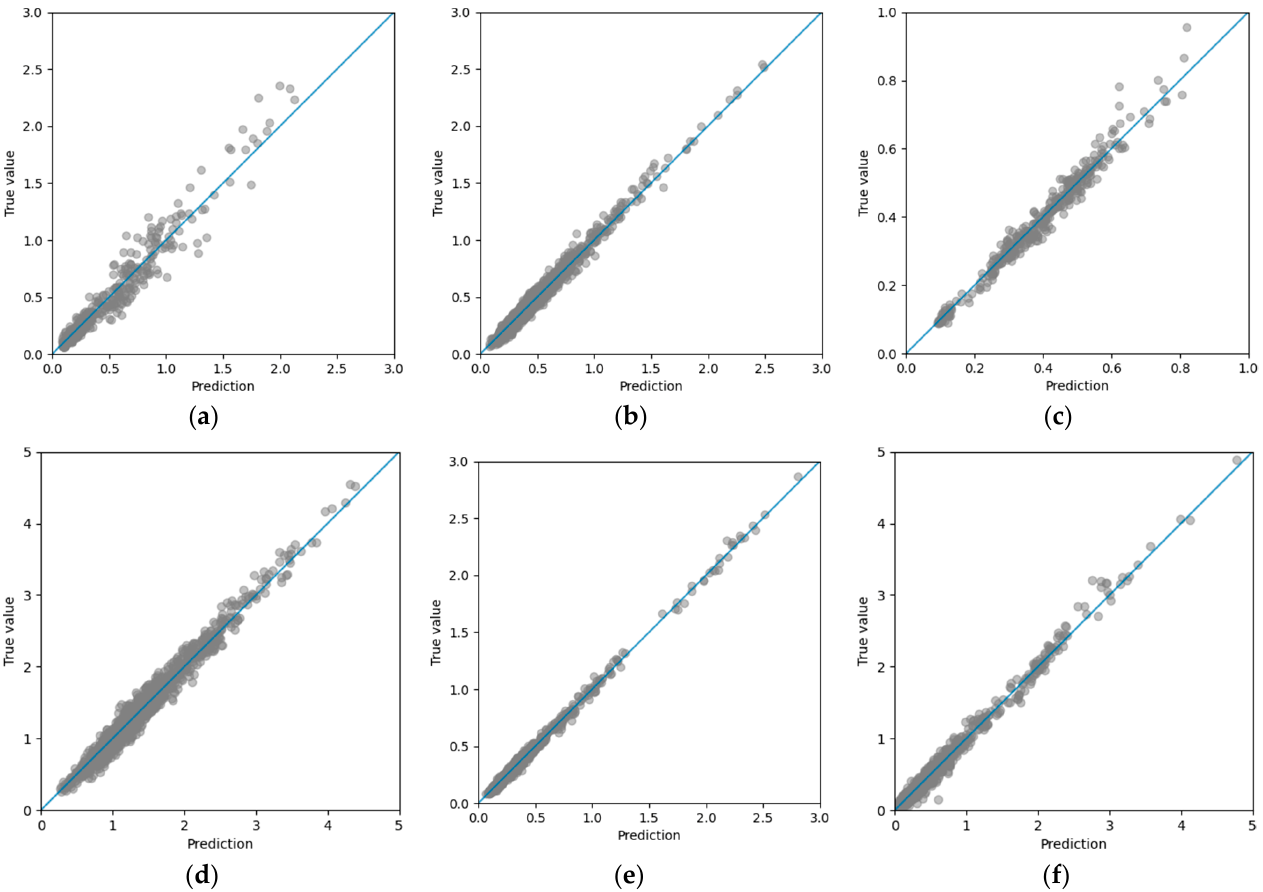
Figure 5. Training error for ( a ) surge, ( b ) sway, ( c ) heave, ( d ) roll, ( e ) pitch and ( f ) yaw gradient boosting models.